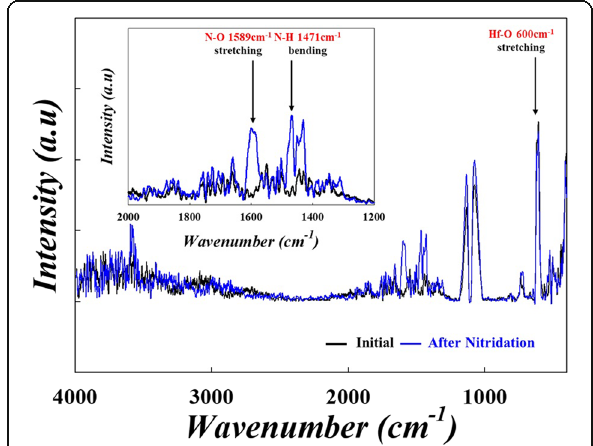
Fig. 3 The comparison of FTIR spectra of HfO 2 thin films between initial and after nitridation